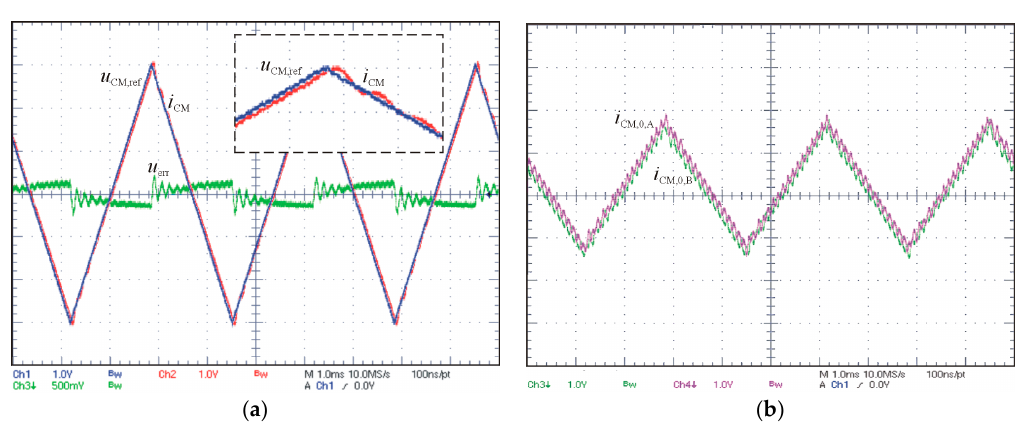
Figure 16. Selected waveforms in the laboratory prototype of the current modulator, with the CM operating in a dual-channel configuration ( a ). In ( b ) the currents in the individual channels of the modulator are shown. The modulator’s output current magnitude is equal to the nominal one. Horizon scale = 1 ms/div, vertical scale = 4A (4V)/div (2 V/div for the error signal).